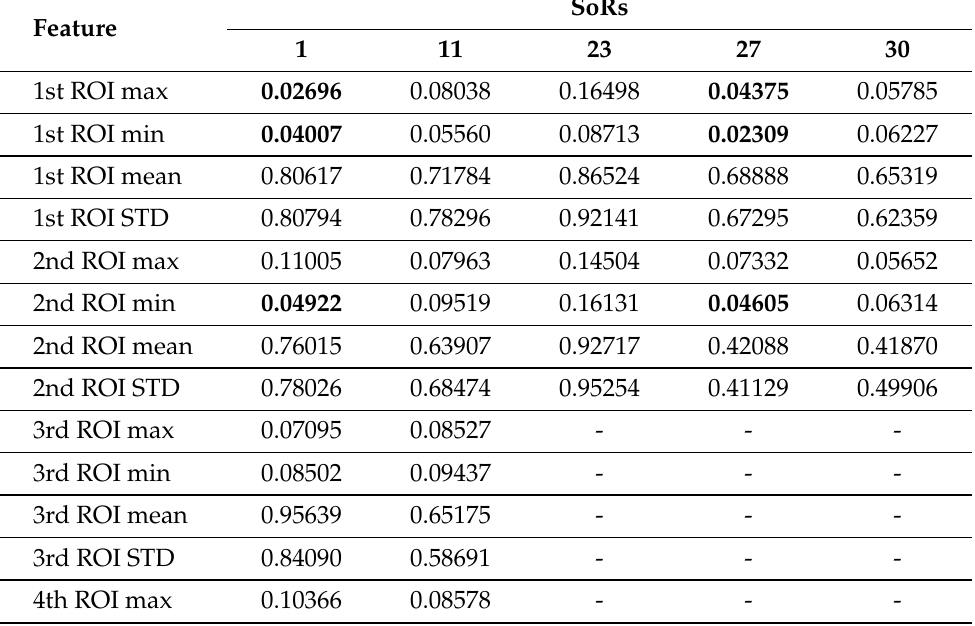
Table 11. p -values for features on SoRs with values above required threshold.